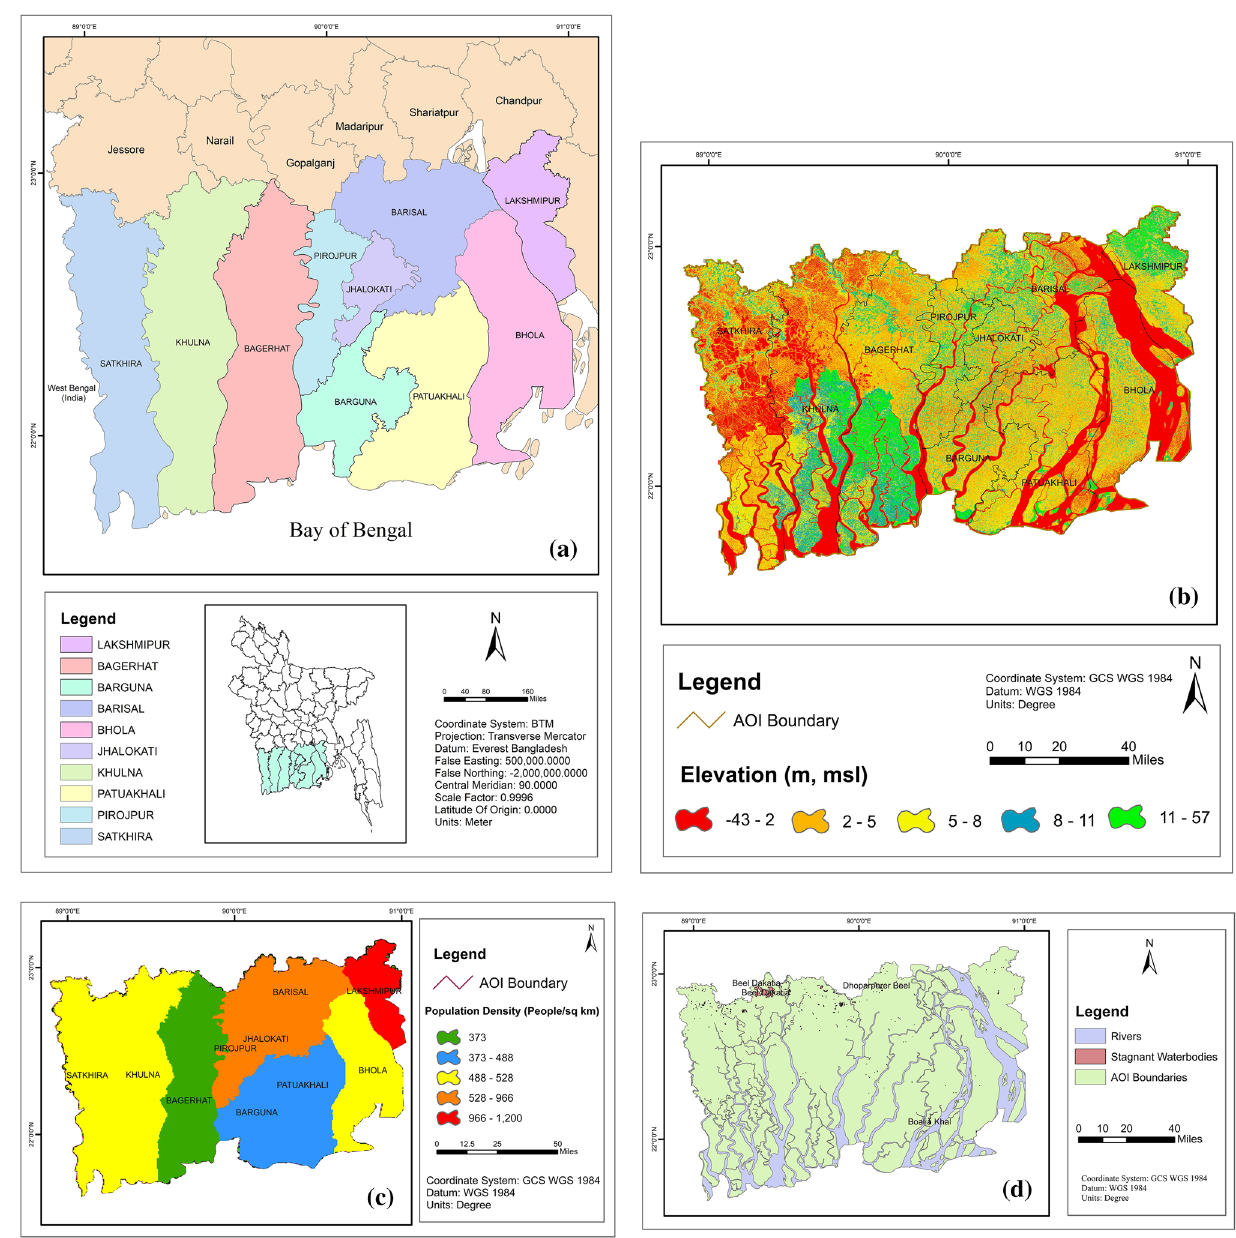
Fig. 1 a Southwestern and central coastal districts of Bangladesh; b elevation-level distribution at district level; c population density of the southwestern and central coastal districts; d river and stagnant water bodies distribution of southwestern and central coastal